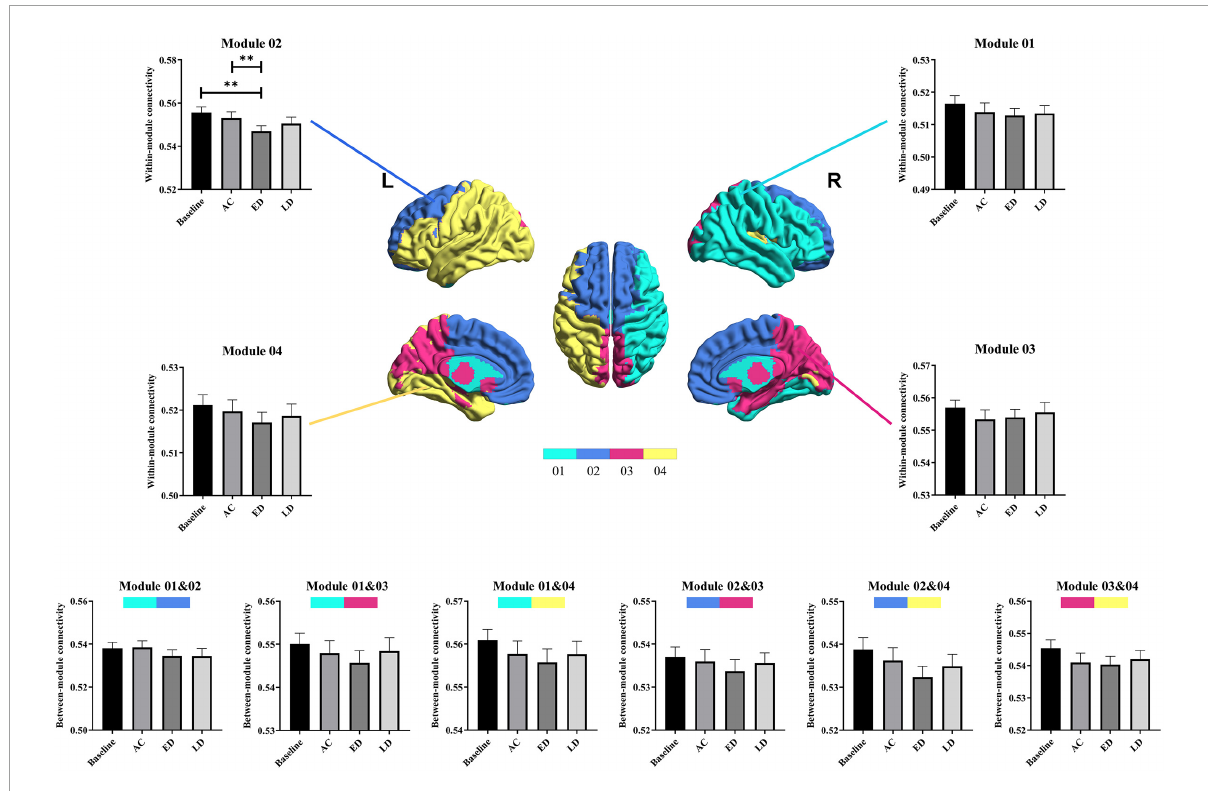
FIGURE3 The post-hoc pairwise comparison results of the global network measures for four time stages (the baseline, post-RT-AC, post-RT-ED, and post-RT-LD) after false discovery rate (FDR) correction. AC, post-RT-AC; ED, post-RT-ED; LD, post-RT-LD; ** p <